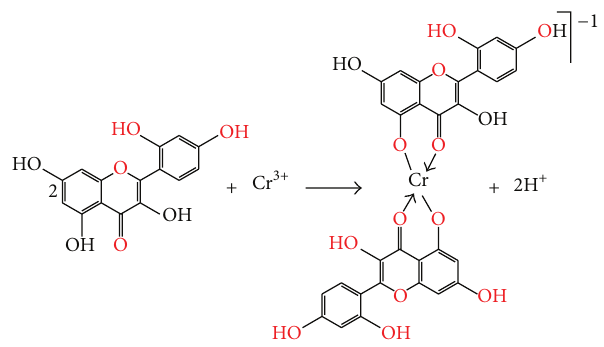
Scheme 1: Proposed chemical reaction between Cr(III) metal ion and morin ligand